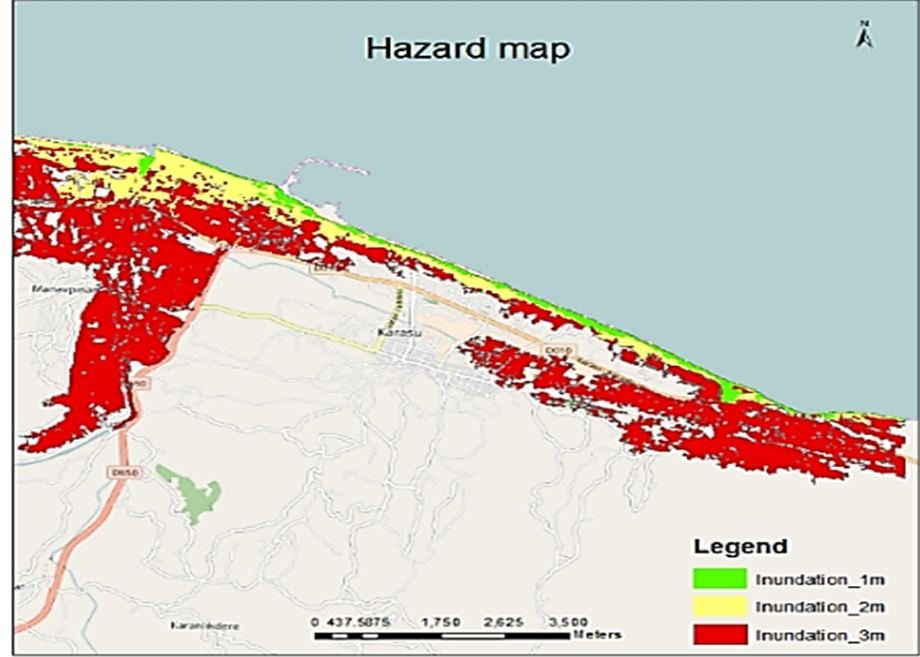
Figure 4. The DEM shows the low-lying land that is broader on the western shore [37].